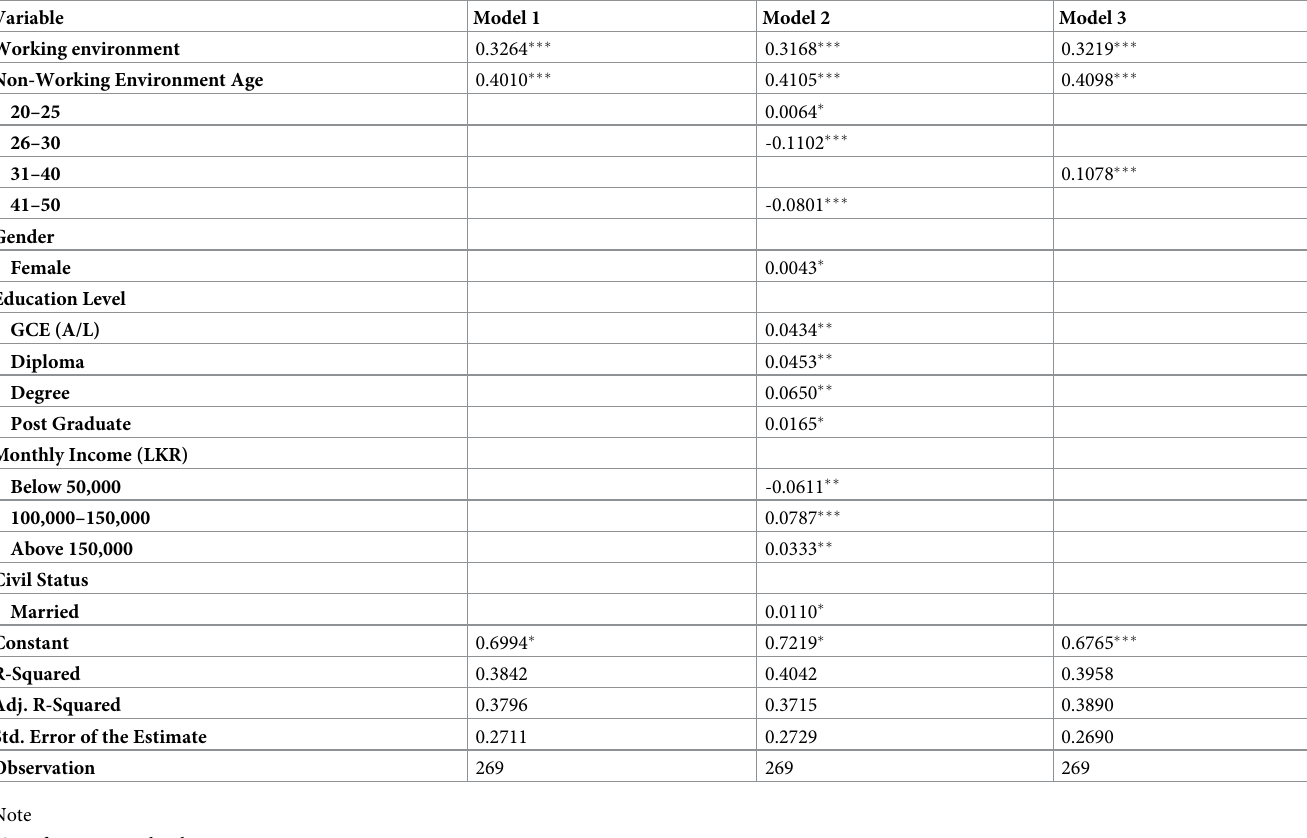
Table 5. Regression results-on